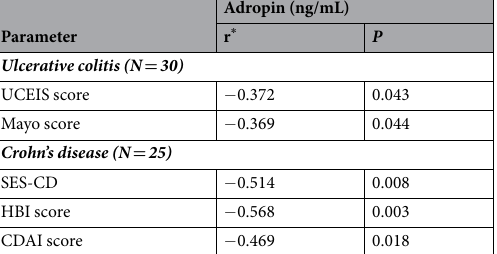
Table 4. Correlation analysis between different IBD severity scores and serum adropin levels. Abbreviations: UCEIS- Ulcerative Colitis Endoscopic Index of Severity; SES-CD - Simple Endoscopic Score for Crohn’s Disease; HBI - Harvey Bradshaw Index; CDAI - Crohn’s Disease Activity Index. * Spearman rank correlation coefficient.